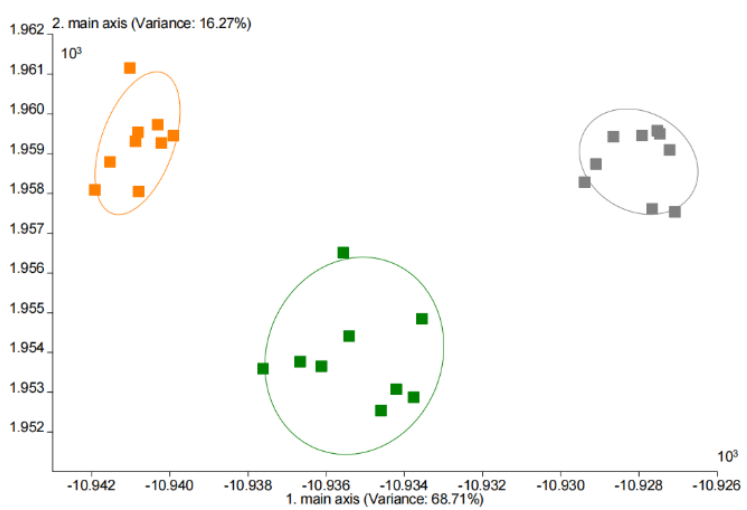
Figure 11. The LDA analysis of different yogurts (CY in gray, NY in orange, and MY in green).